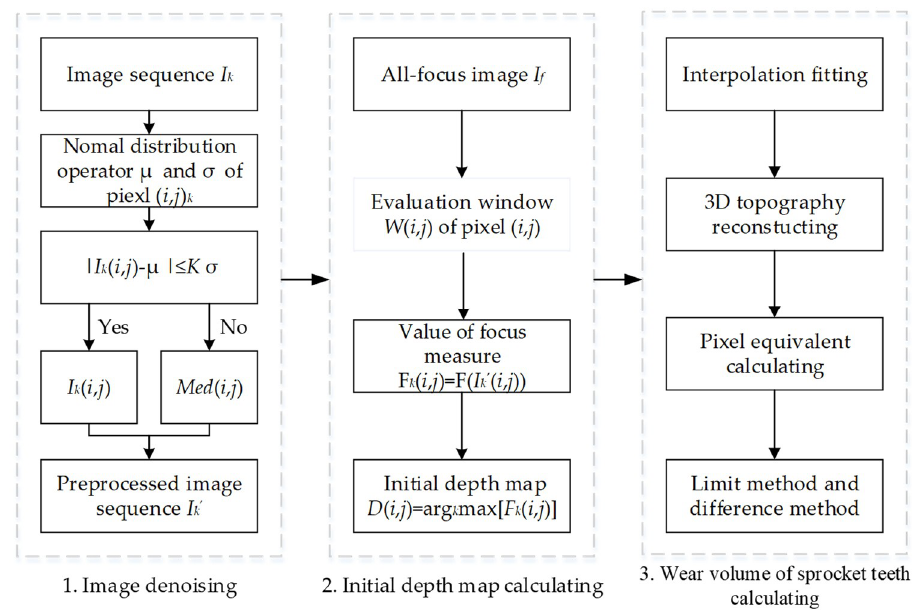
Figure 13. Process of the improved SFF algorithm.